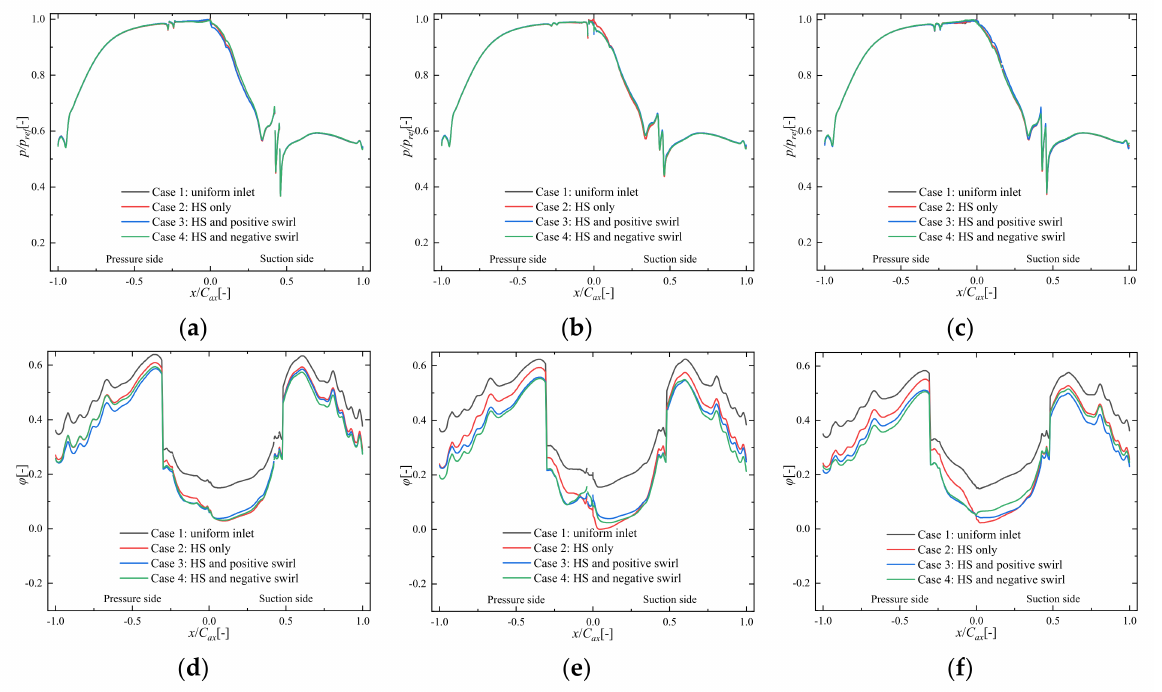
Figure 13. Pressure and overall cooling effectiveness profiles along the vane surface. ( a ) pressure at z = 25% span; ( b ) pressure at z = 50% span; ( c ) pressure at z = 75% span; ( d ) overall cooling effectiveness at z = 25% span; ( e ) overall cooling effectiveness at z = 50% span; ( f ) overall cooling effectiveness at z = 75%